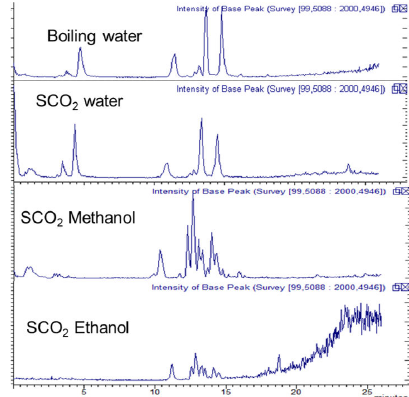
Figure 2. LC/ESI-MS TIC chromatogram of the Eruca extract obtained with boiling water SCO 2 with co-solvent water, methanol and ethanol (8%